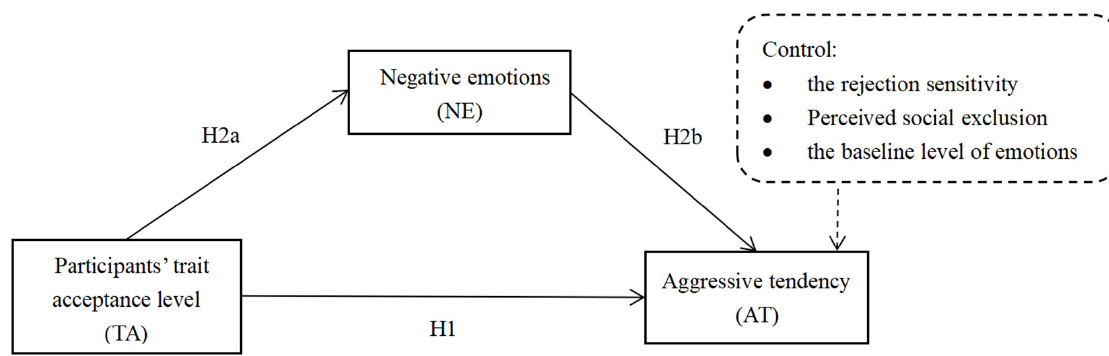
Figure 1. Hypothesized conceptual